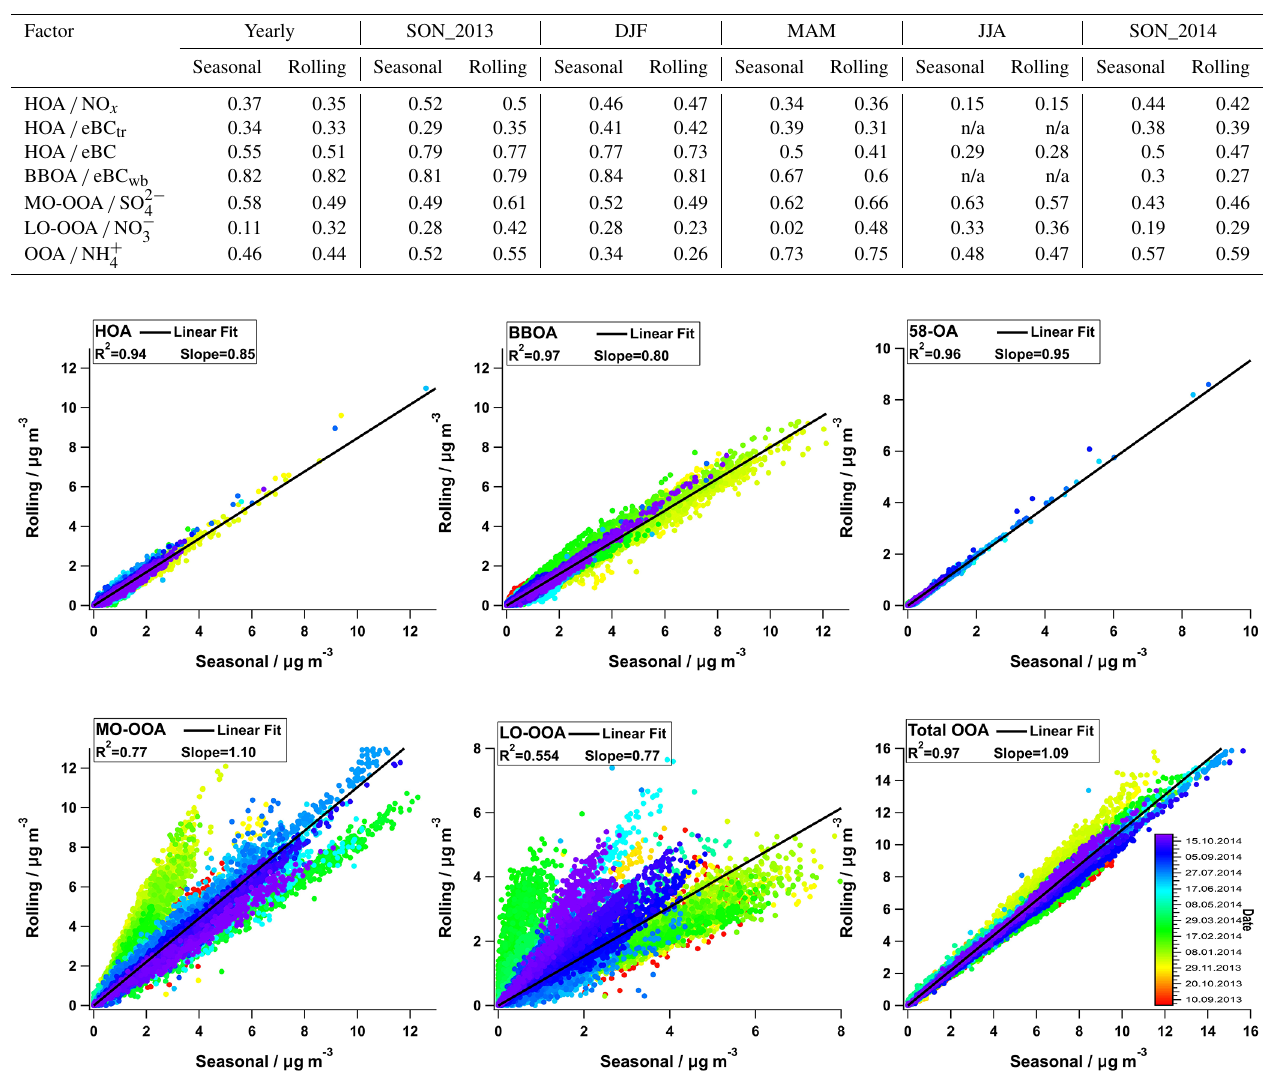
Figure A1. Comparison of the mass concentrations resulting from rolling PMF and from the seasonal analysis for each factor (colour-coded by date and